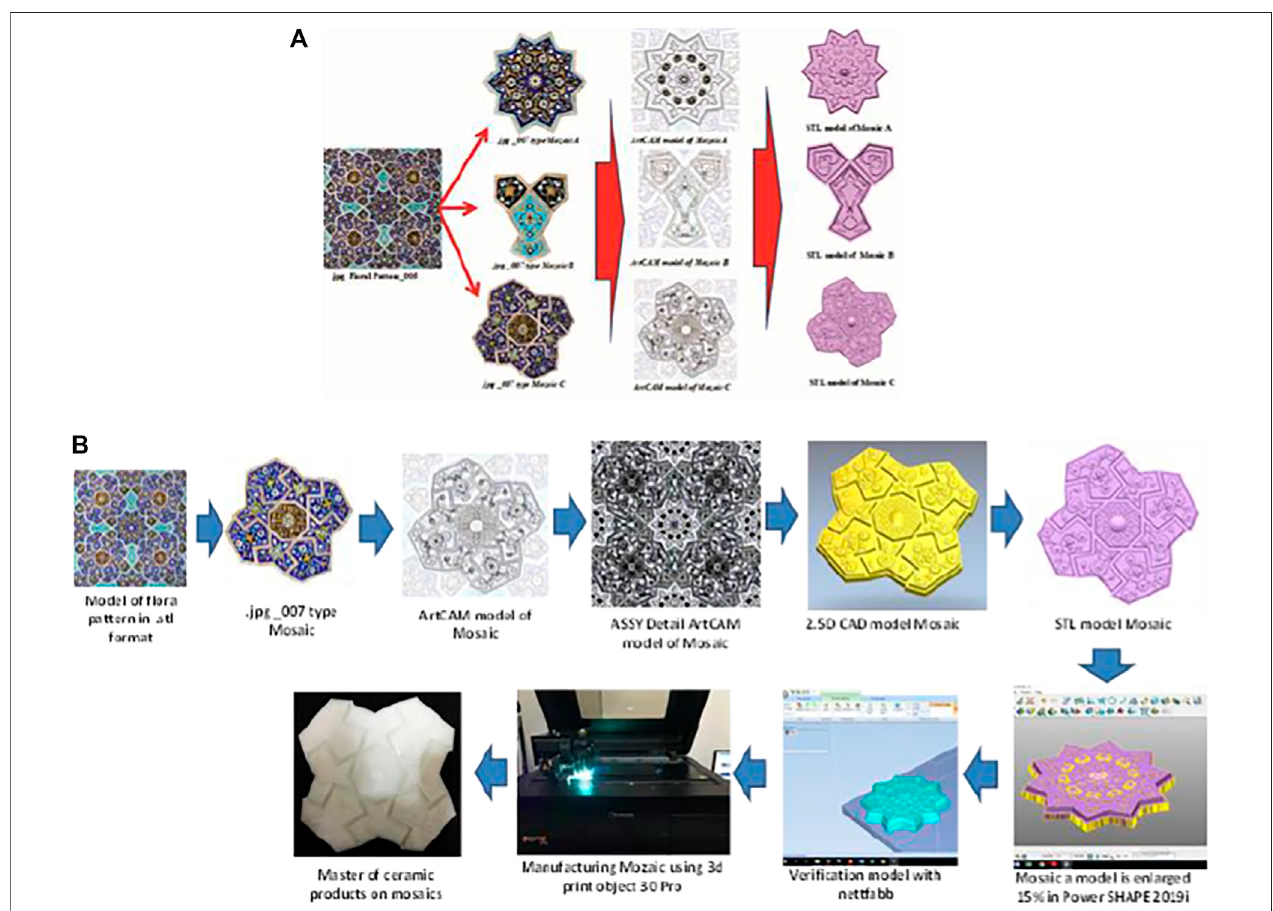
FIGURE 2 | Design process for the production of Islamic ceramic tile puzzle walls: (A) vector generation in ArtCAM 2015R2; (B) design to manufacture of master product tile wall using 3D printing.